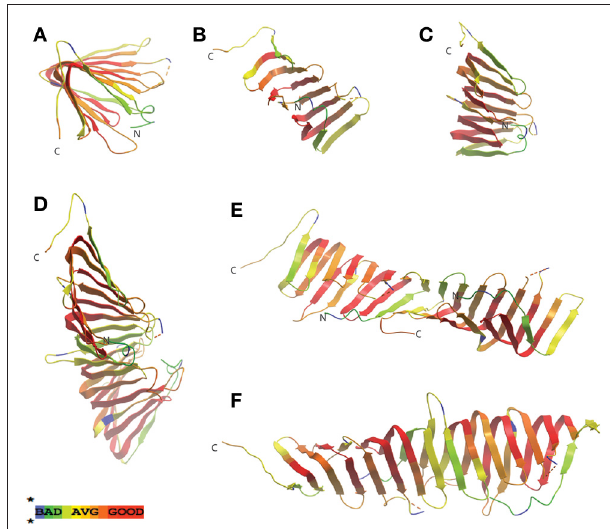
generated, described previously in Figure 2 . Crystal structures of LptA from E. coli [PDB ID: 2R19, (Suits et al., 2008)] were then used as a template for mapping the similarity scores. Monomeric (A–C) , as well as the dimeric (D–F) “head-to-tail” conformation (in which the N-terminal β -strand from each molecule interacts with the C-terminal β -strand of the adjacent LptA molecule) of protein structures are shown. Greatest similarity is found in the central portions of the protein (shown in red) whereas areas believed to be involved in monomer stacking to form filamentous structures, believed to potentially span the periplasm, give significantly lower similarity scores (shown in yellow and green). The dotted yellow and red lines in the model represents regions in the amino acid protein sequence not present in the solved crystal